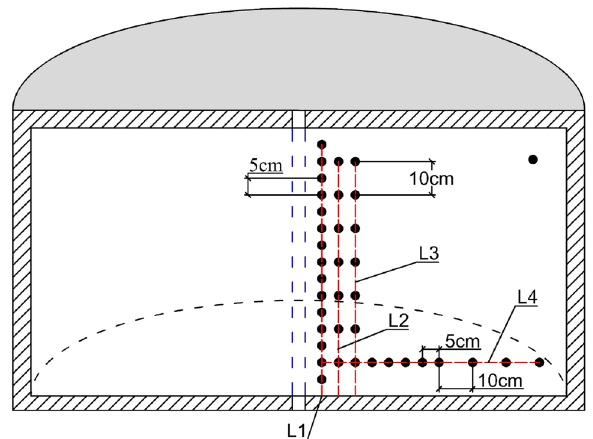
Fig. 4 Distribution of temperature measurement points inside the